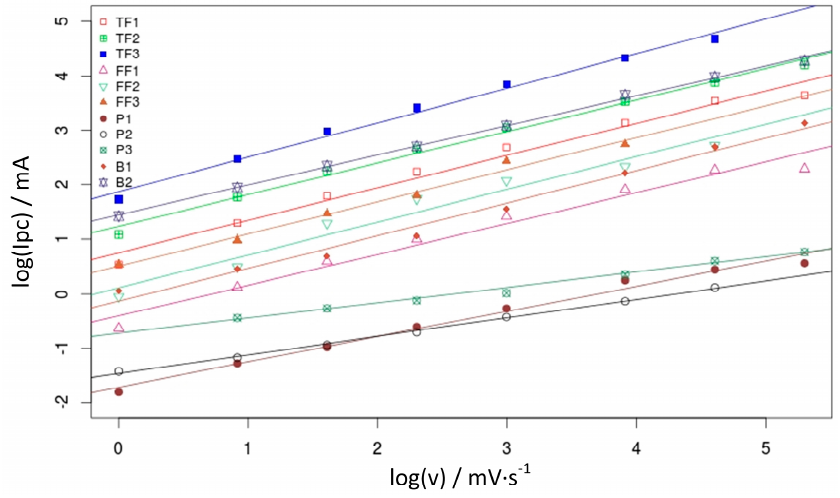
Figure 5. Linear trend in the logarithmic representation of I pc vs. υ .